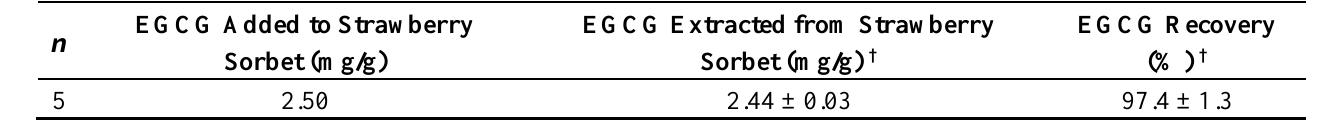
Table 2. Recovery of EGCG from the strawberry